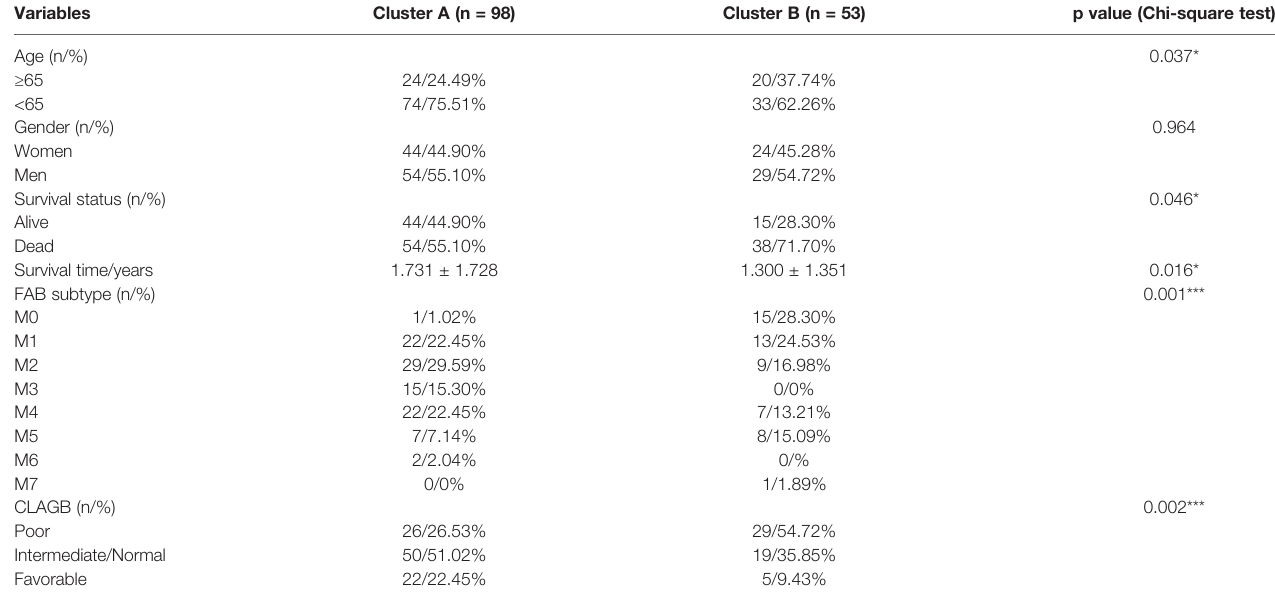
TABLE 1 | Comparison of clinical information between pyroptosis-related subtypes in AML patients.